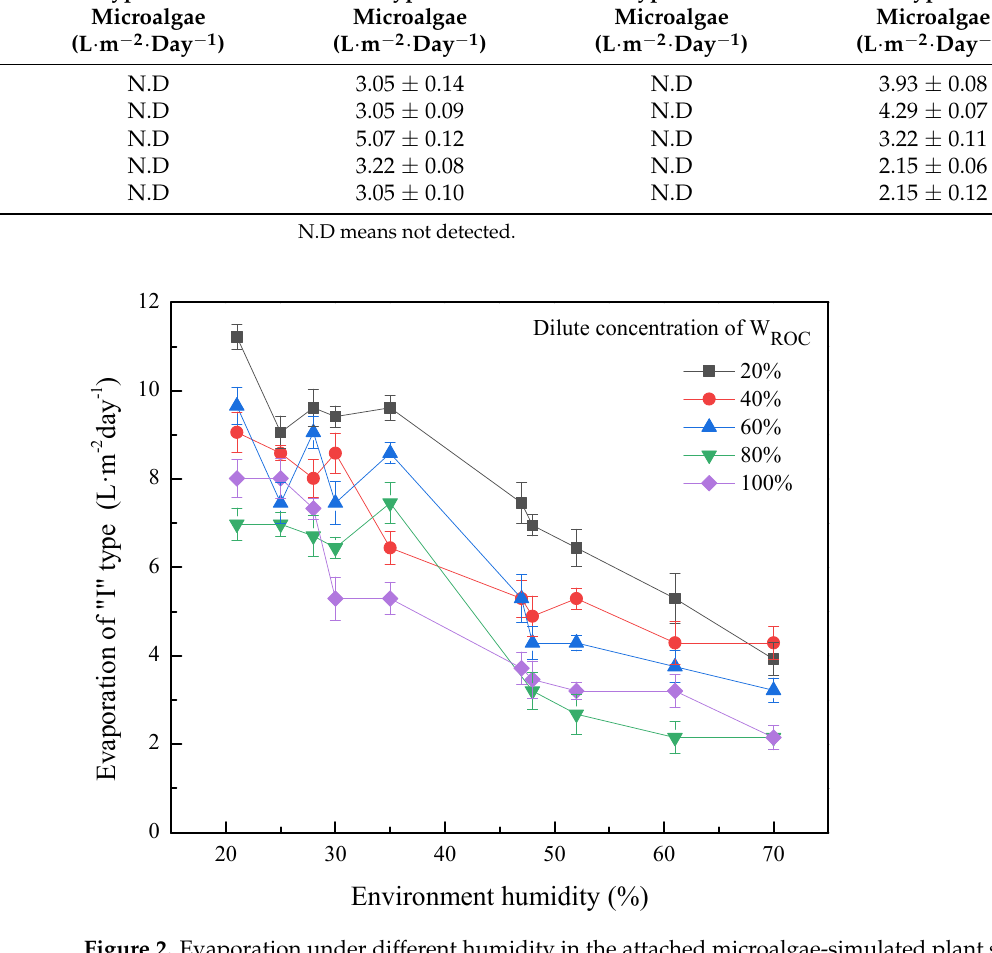
Figure 2. Evaporation under different humidity in the attached microalgae-simulated plant system.